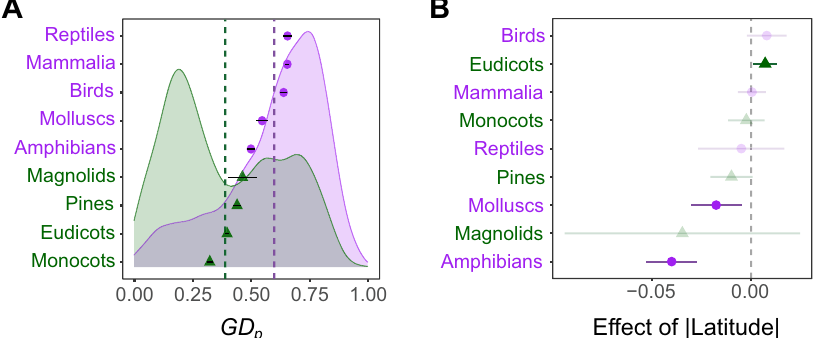
Fig. 2 Population genetic diversity (GD P ) across the plant (green) and animal (purple) kingdom. A density plot ( A ) shows the distribution of raw GD P values in plants and animals, with 95% con fi dence interval error bars of phylum means. Phylum-speci fi c slopes (with 95% con fi dence intervals derived from the Phylum model; Supplementary Data 5) of the absolute latitude effect (i.e. distance to equator) show that diversity only decreases away from the equator in amphibians and molluscs, and even increases in eudicot plants ( B ). Non-signi fi cant slopes (p-values > 0.05) are transparent. Source data are provided as a Source Data fi